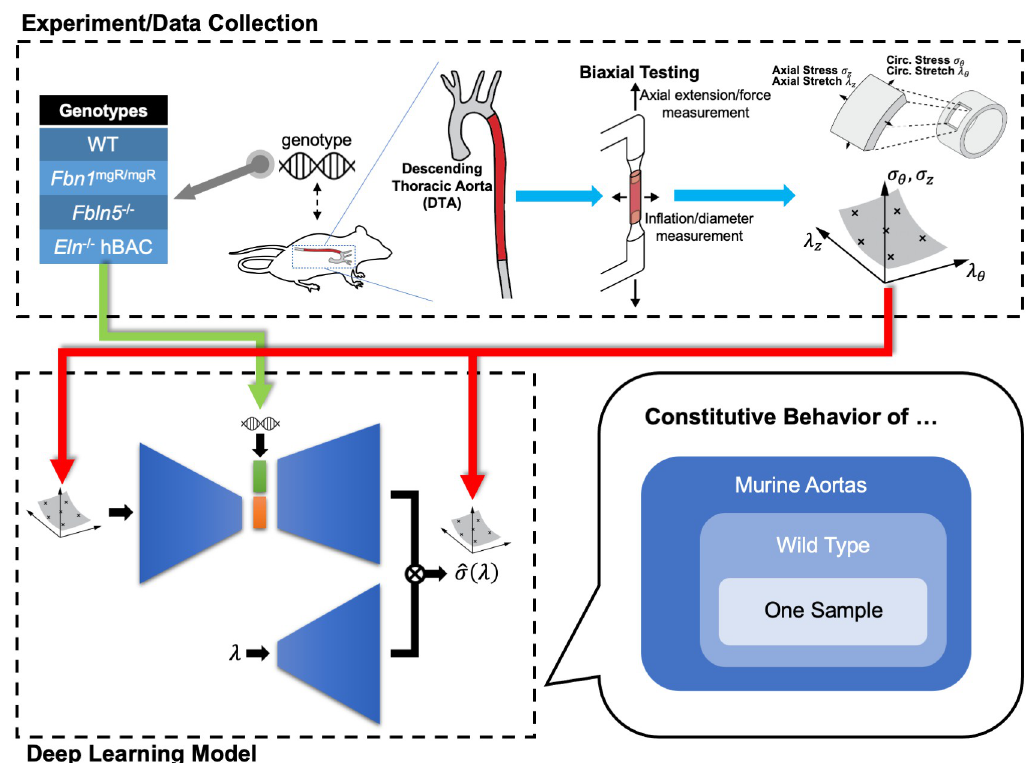
Fig 1. Overview of the workflow in G2 F net with experimental measurements informing the deep learning model. We use biaxial tests to measure the biomechanical properties of the descending thoracic aorta (DTA) from mice with different mutations that affect the elastic fibers. Through the experimental measurements, circumferential ( σ determined for different combinations of circumferential ( λ θ ) and axial ( λ z ) stretch. We then use the experimental results to train our deep learning model to capture the aortic constitutive relation in a hierarchical way: general mechanical behavior across multiple genotypes, behavior for a certain genotype, and behavior for a certain sample of a certain genotype. We view genotypes as material classes that possess distinct biomechanical properties. Illustrative data are shown in Fig 2. The detailed architecture of our deep learning model is explained in Fig